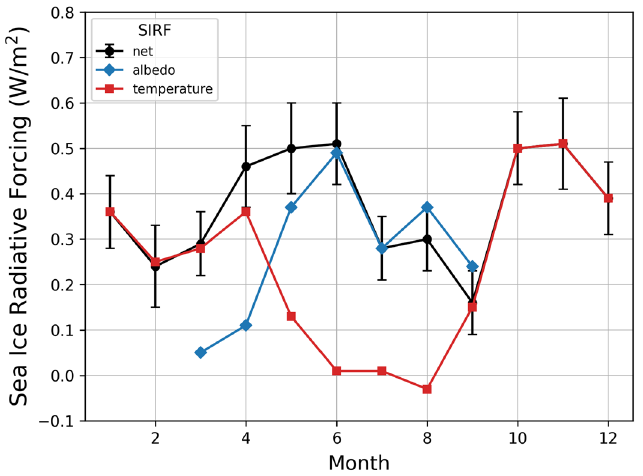
Figure 8. The SIRFs monthly changes for each factor from 1982 to 2015.